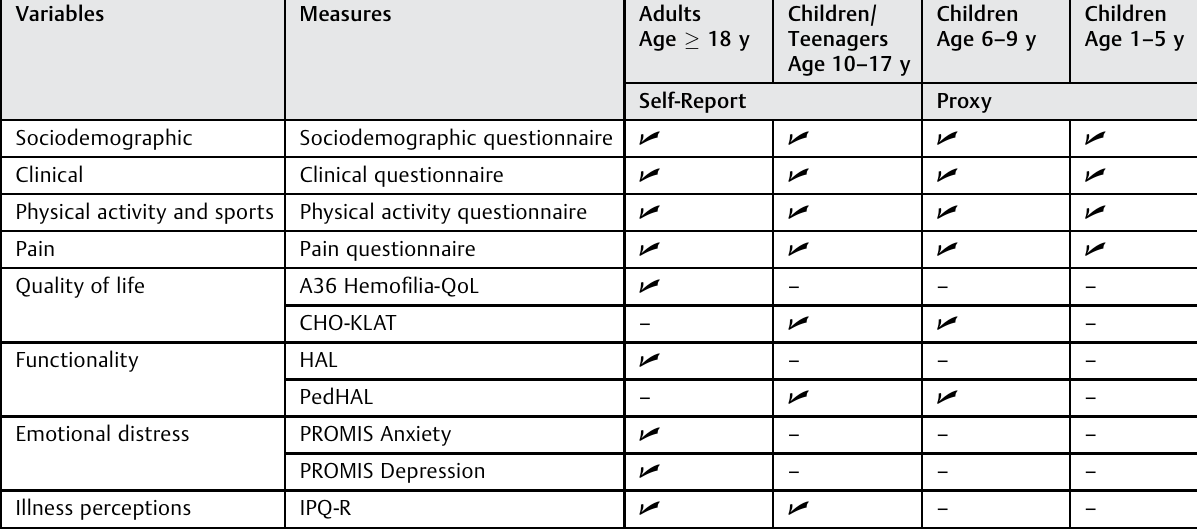
Table 1 Survey versions, variables, and questionnaires